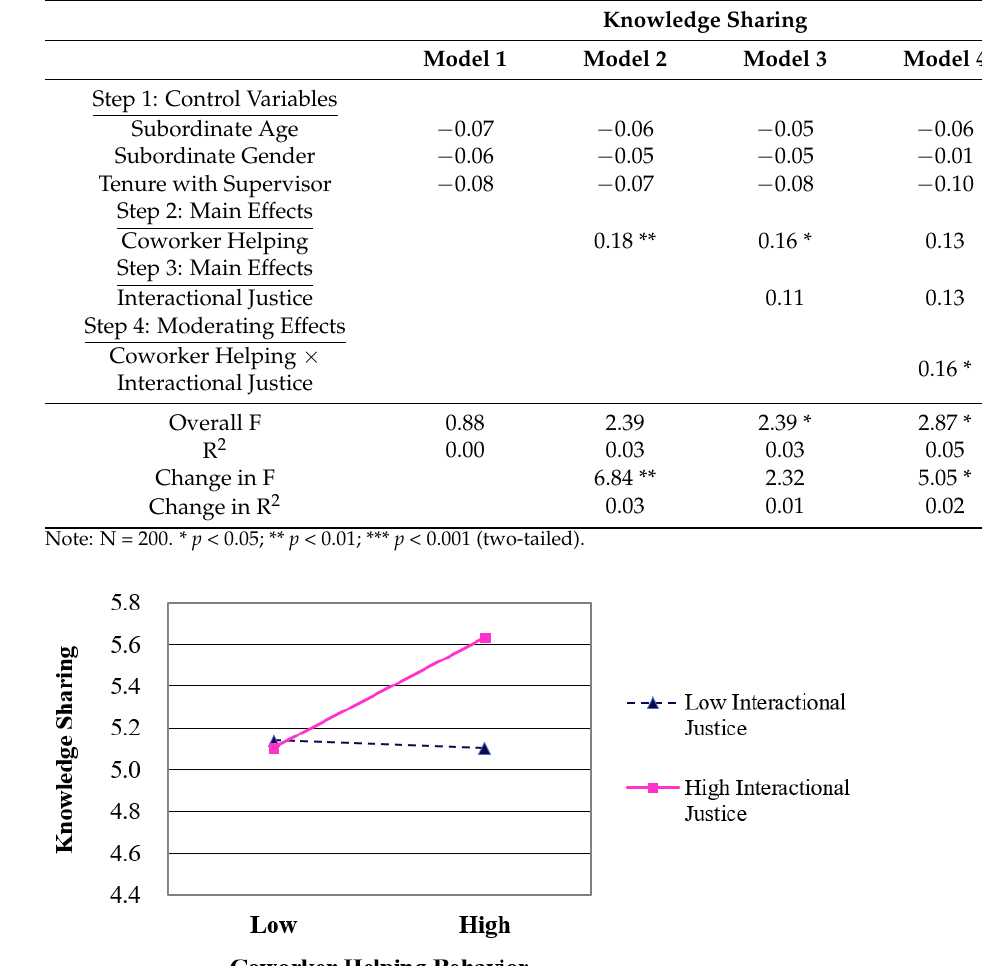
Table 4. Results for the moderating effect of interactional justice.